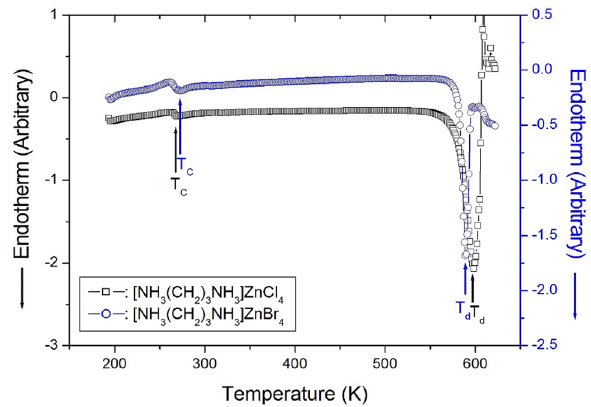
Figure 3. Differential scanning calorimetry (DSC) thermogram of [NH 3 (CH 2 ) 3 NH 3 ]ZnCl 4 and [NH 3 (CH 2 ) 3 NH 3 ] ZnBr 4